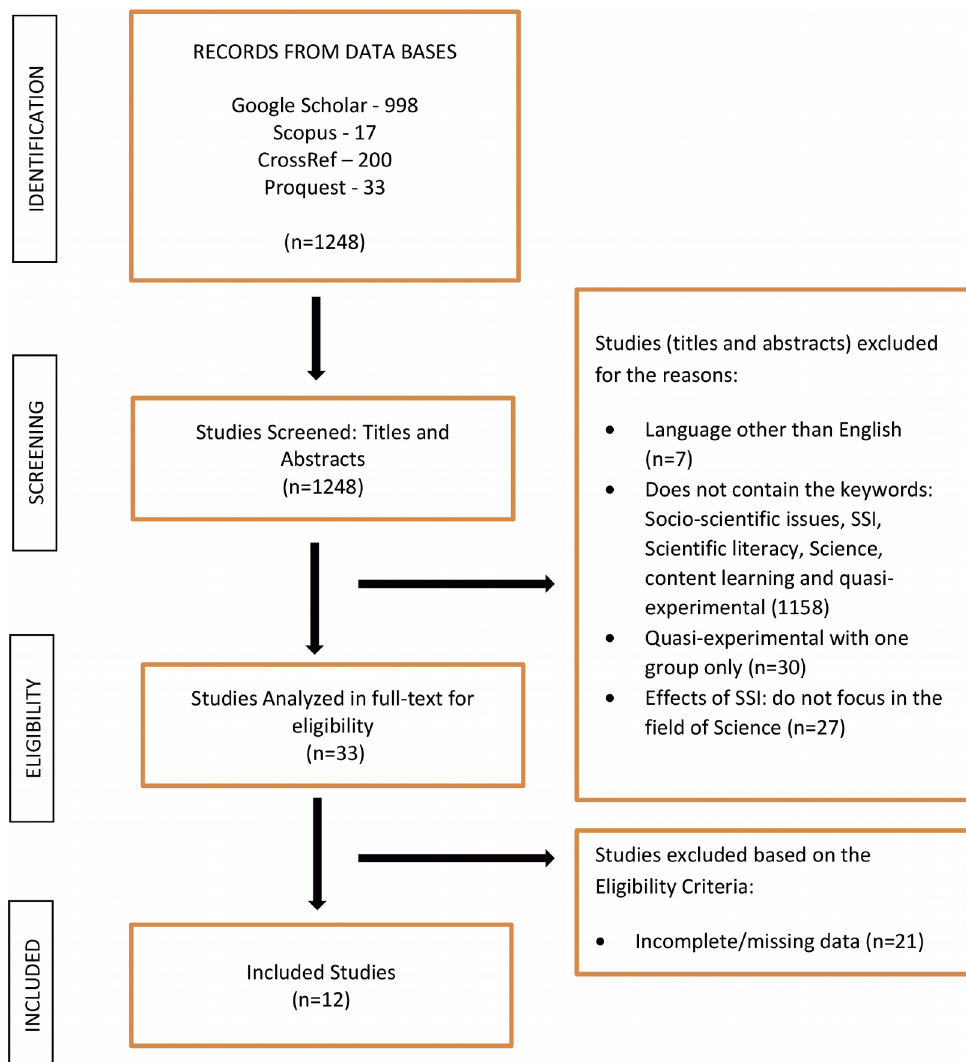
Figure 1. Research Studies Selection using PRISMA (Hak et al.,